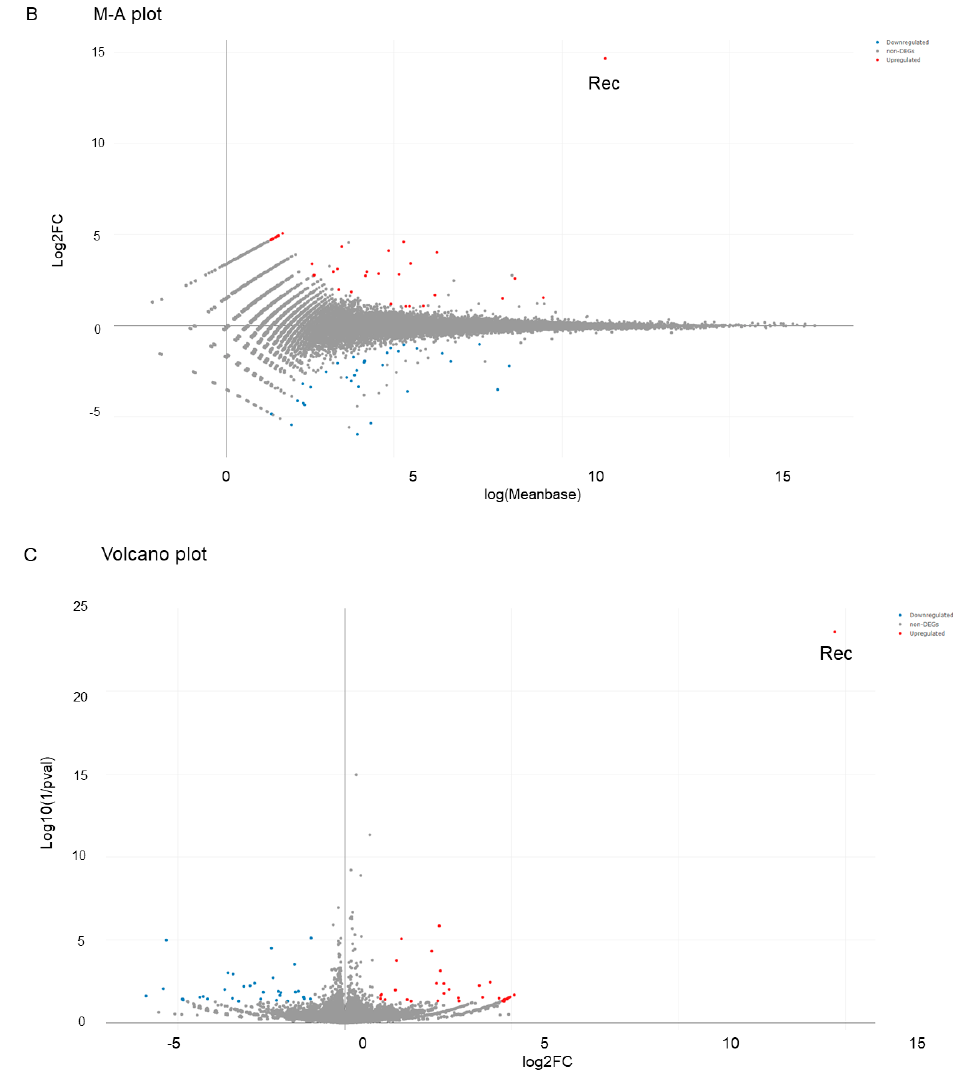
Figure 6. Differently expressed genes (DEGs) between A549 MOCK and A549 Rec cells. In total, 88 genes were expressed differently (fold-change ≧ 2.0 and FDR adjusted p -Value < 0.05 and q < 0.08) between A549 Mock and A549 Rec cells are shown by a hierarchical clustering heatmap (panel ( A ), A549 Mock; gray, A549 Rec; orange), M–A plots (panel ( B )) and volcano plots (panel ( C )). M–A plot represents the relationship between the mean expression values [log (baseMean); x -axis] and the magnitude of change in gene expression (log2 of fold-change; y -axis), and volcano plot represents the relationship between the magnitude of gene expression change (log2 of fold-change; x -axis) and statistical significance of this change [-log10 of false discovery rate (FDR); y -axis].